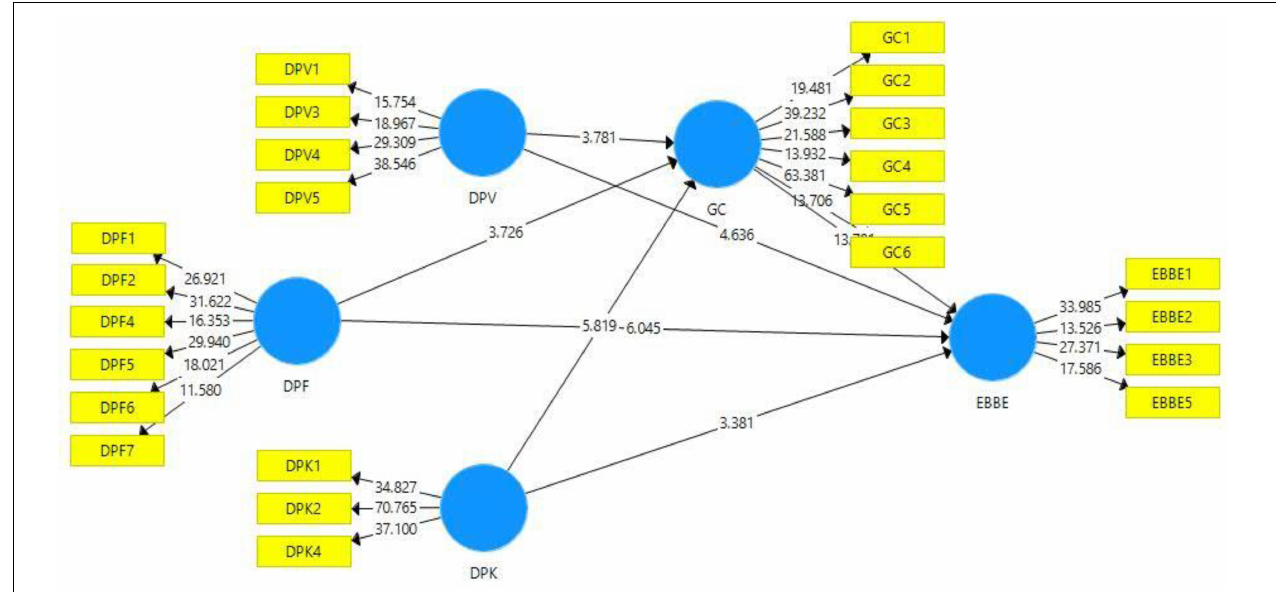
FIGURE 2 | Path estimates and outer loadings.